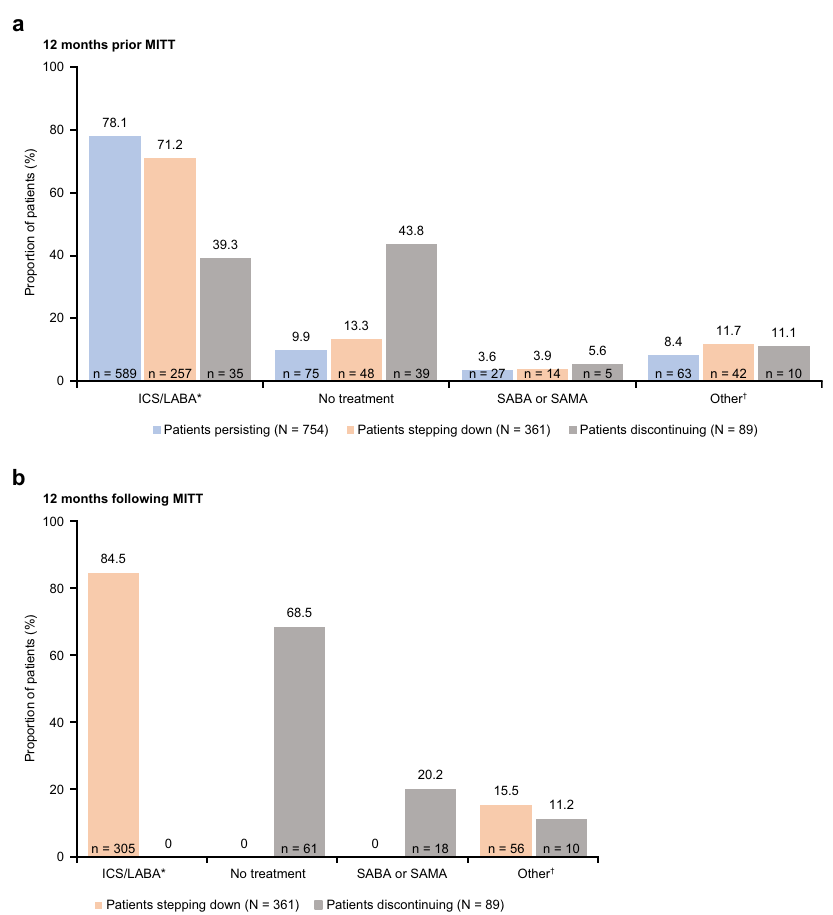
Fig. 4 Treatment patterns in patients that persist, step-down and discontinue MITT. a 12 months prior to (pre-index) and b 12 months following (post-index) MITT initiation. Percentages may not total 100% due to rounding. *ICS/LABA category includes: ICS/LABA, ICS/LABA/ anti-leukotrienes, ICS/LABA/OCS, ICS/LABA/OCS/SAMA, ICS/LABA/anti-leukotrienes/OCS; † other category includes: ICS, ICS/LAMA, ICS/anti- leukotrienes, ICS/OCS, ICS/OCS/LAMA, LABA/LAMA, LABA/anti-leukotrienes, LAMA, LAMA/anti-leukotrienes, anti-leukotrienes, OCS, OCS/ LAMA, OCS/LAMA/anti-leukotrienes. ICS inhaled corticosteroid, LABA long-acting β 2 -agonist, LAMA long-acting muscarinic antagonist, MITT multiple-inhaler triple therapy, OCS oral corticosteroid, SABA short-acting β 2 -agonist, SAMA short-acting muscarinic